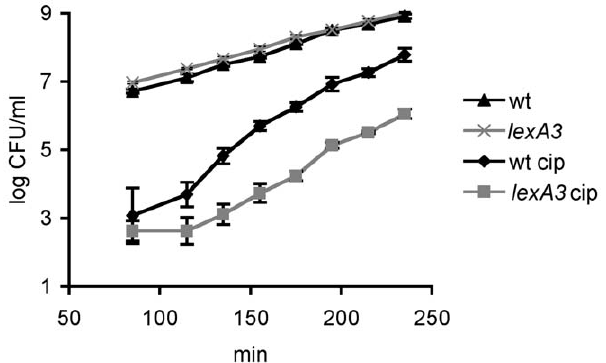
Figure 6. Growth phase and persister formation. Wild-type strain and strain unable to induce SOS ( lexA3 ) were cultured with aeration at 37 u C. A sample of each culture taken at the designated time points was treated with ciprofloxacin for 3 hrs. Cell counts before and after the antibiotic challenge were determined by plating. Data points are averages of 4 independent experiments. Error bars represent standard error.